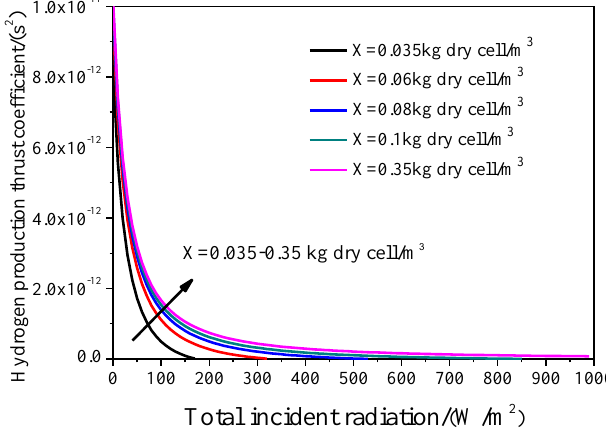
Figure 6. The curves of hydrogen production thrust coe ffi cient varying with light intensity and microalgae concentration.